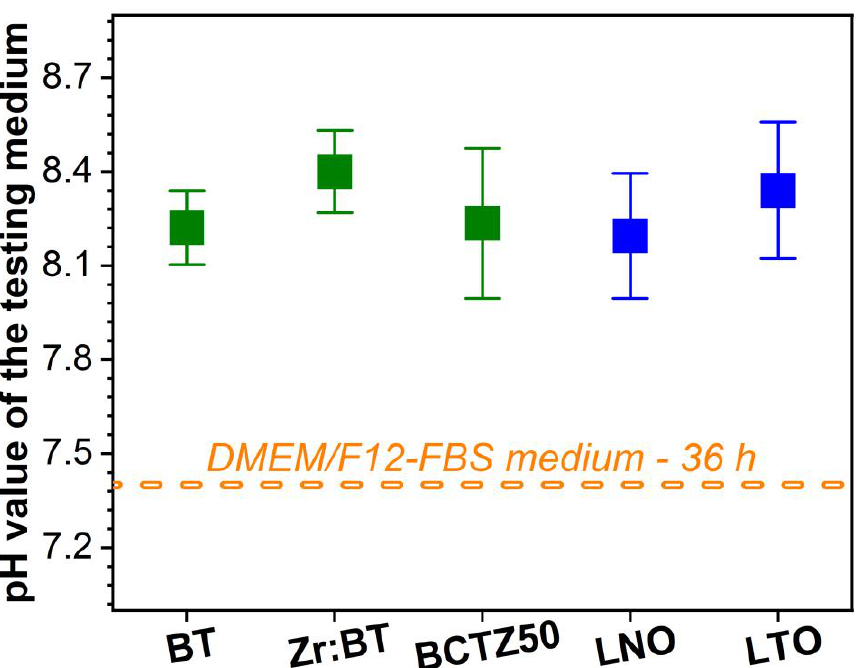
Figure 8. pH value of the DMEM/F12-FBS cell culture medium after 36 h of incubation in the presence of BT, Zr:BT, BCTZ50, LNO and LTO sintered ceramics.